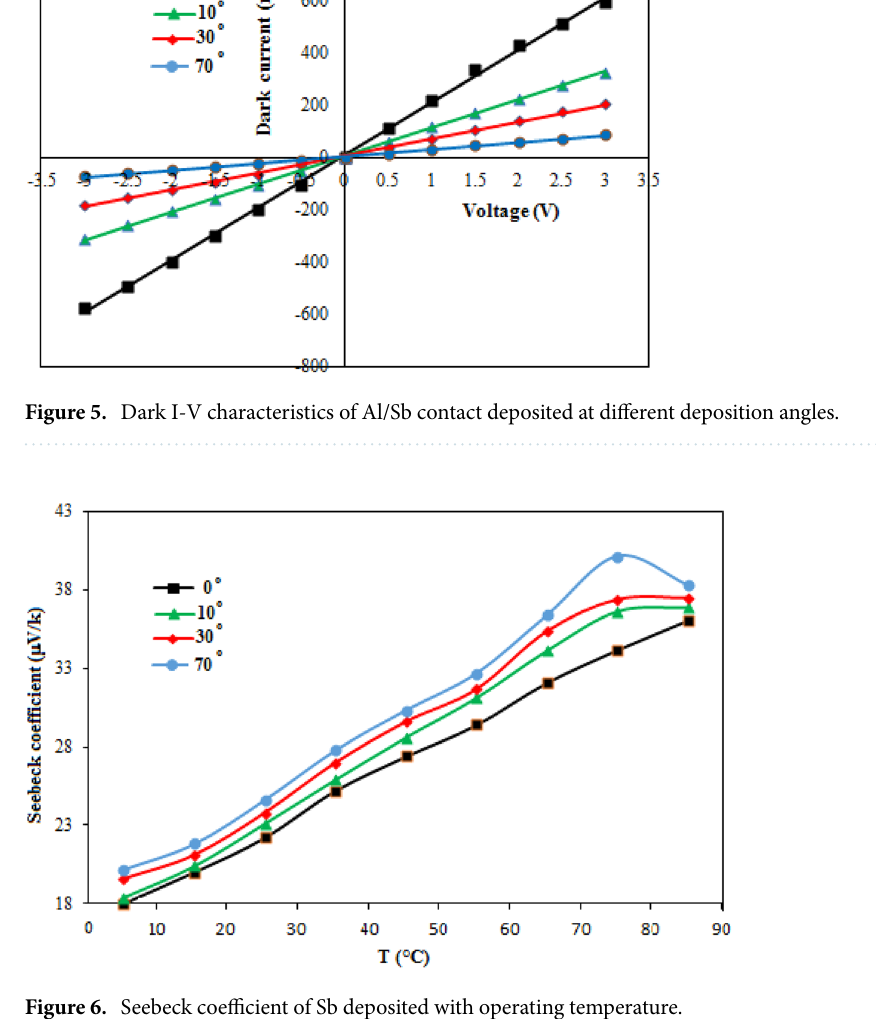
Figure 6. Seebeck coefficient of Sb deposited with operating